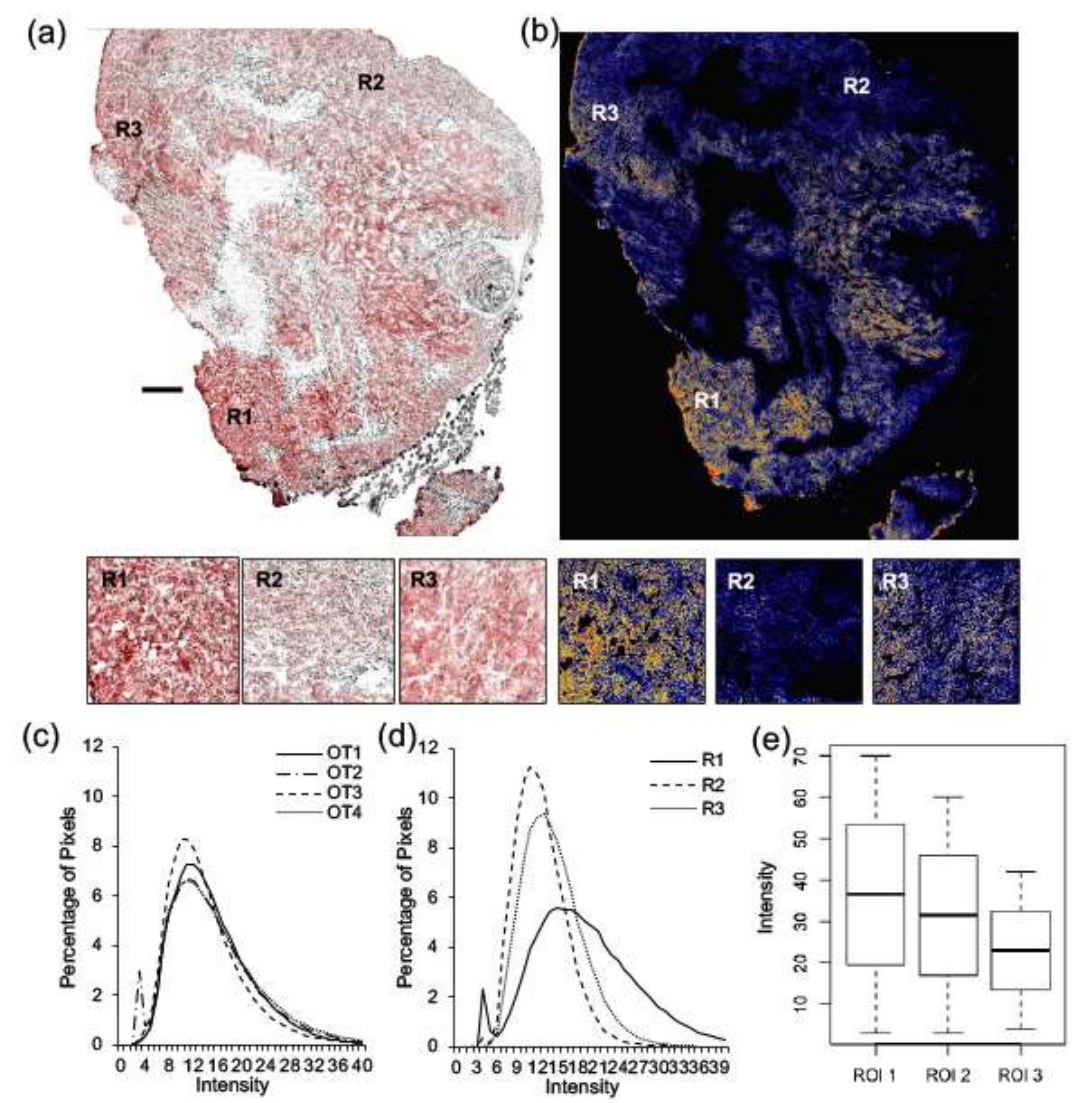
Figure 3. Significant intra-tumoral heterogeneity of Her2/neu expression is observed in orthotopic tumors. Tissue sections of orthotopic tumors were probed for Her2/neu expression and imaged for Her2/neu (red) and Hoechst (grey) ( n = 4). A representative image of an orthotopic tumor is shown ( a ), selected regions from the tumor that represent high expression levels (R1), low expression levels (R2), and moderate expression levels (R3) are shown where grey represents nuclei, and red Her2/neu expression. A heat map was generated from the greyscale image of Her2/neu fluorescence ( b , R1, R2, R3), where red represents strong staining, yellow moderate staining and blue weak staining. Her2/neu expression was evaluated for heterogeneity by plotting the distribution of pixels across intensity levels from 0 to 255 for four orthotopic tumors ( c ), and for three ROI within one orthotopic tumor ( d ). Boxplots were used to illustrate the distribution of pixels across intensity levels for three ROI within one orthotopic tumor, and a Kruskal–Wallis test provided a statistically significant p -value (<0.005). ( e ). Bar = 250 µm.